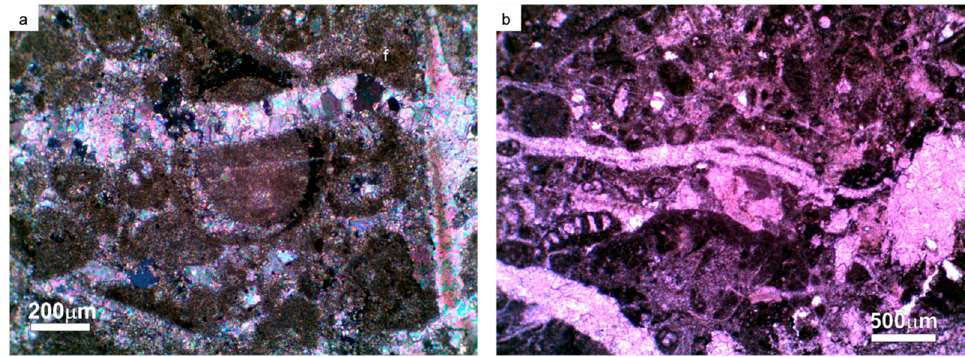
Figure 3. Optical microphotographs of intact Prada limestone. Bioclasts and micritic matrix cut by calcite veins ( a ). Detail of molluscs ( b ). Microphotographs were taken under parallel-nicols.